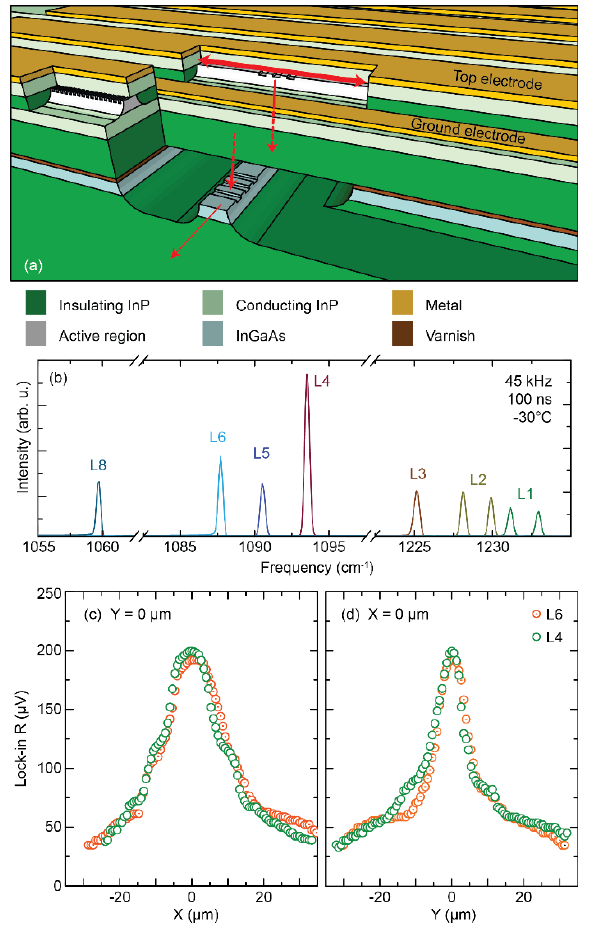
Figure 8. Substrate emitting QCL array with collection waveguide. ( a ) Schematic illustration of the QCL array, depicting the first order DBR, the second order DFB extractor and the bonded second order DFB collector waveguide. The red arrows illustrate the path of the lasing mode; ( b ) laser spectra of the individual lasers in the array; and ( c , d ) near-field amplitude scans of the collector waveguide facet along the X and Y axis during the separate operation of two lasers in the array.